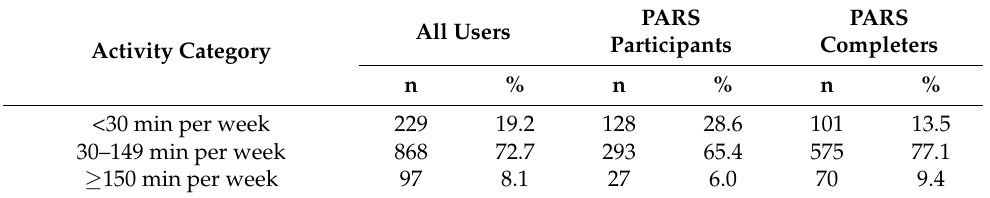
Table 6. Weekly moderate/vigorous leisure centre-based physical